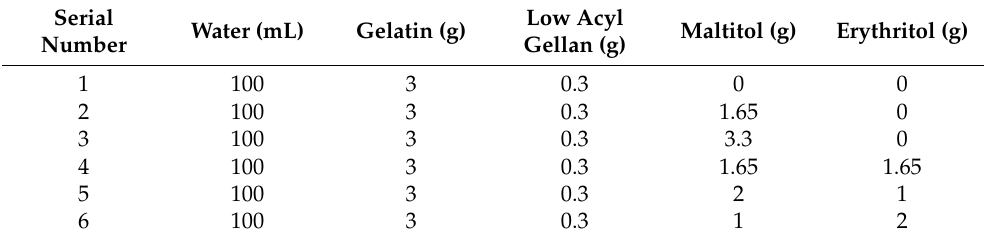
Table 2. Formulation of low concentration polyol gel for